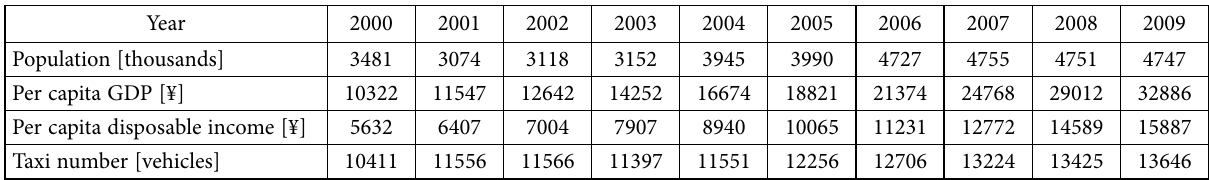
Figure 4. Simulation charts of the basal scenario of Harbin taxi operations Table 3. The basic statistics of Harbin